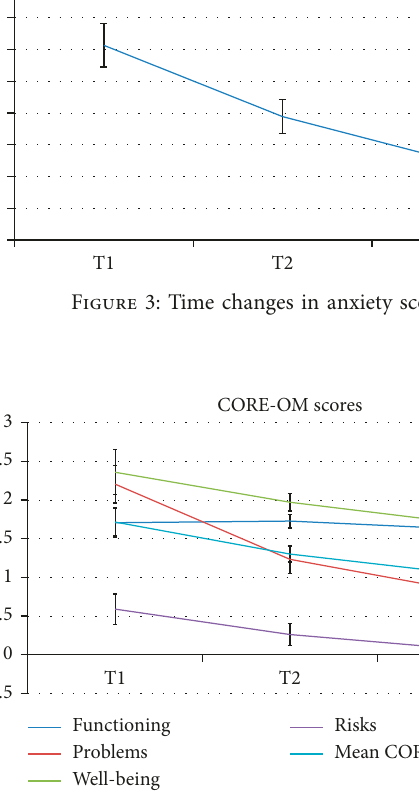
Figure 4: Time changes in the CORE-OM scores.